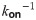
Coefficient of variation (cv) of transcription intervals as a function of relative changes in the parameters kon-1, koff-1, k1-1, and k2-1.The horizontal axis corresponds to the relative value in the specified parameter. The dotted line denotes a cv of unity. The cv at the pivot parameter is 1/2. Left (right) insets represent the asymptotic transcription interval distributions for small (large) parameter values, their color indicating the varying parameter.